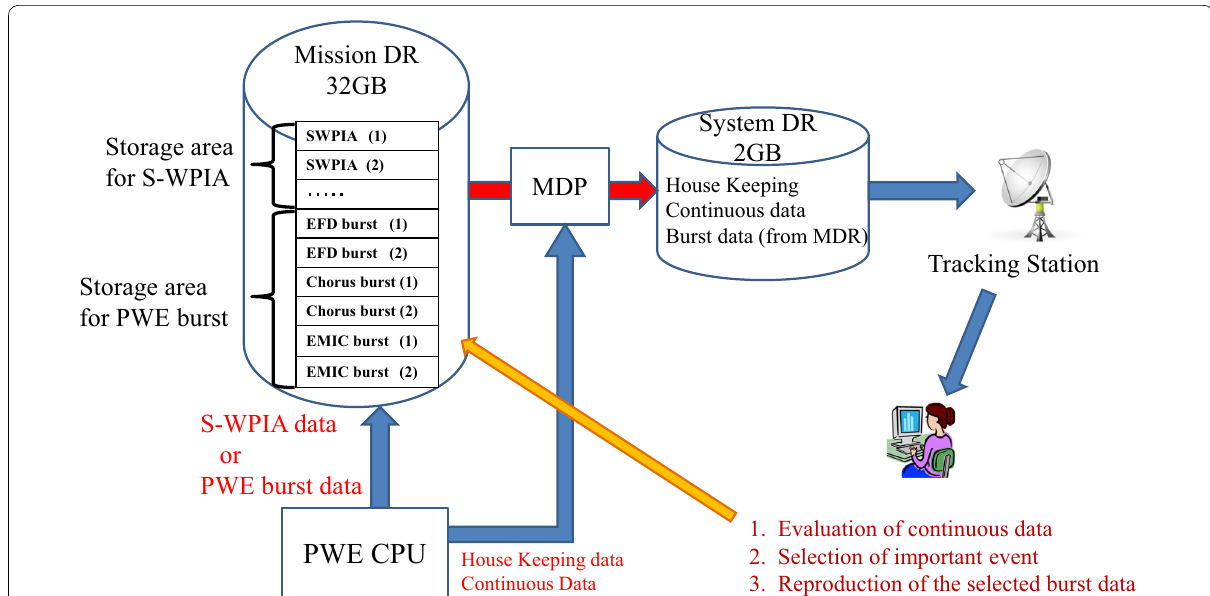
Fig. 18 Data flow of the PWE housekeeping and mission data. The housekeeping and continuous data are sent directly to the system data recorder (SDR) through the mission data processor (MDP). The PWE burst and S-WPIA data are sent to the mission data recorder (MDR) and are stored in a partition corresponding to each data type. In the data selection process, (1) we evaluate the continuous data, (2) select the burst data stored in the MDR, (3) and reproduce the selected burst data. The selected burst data are dumped to the SDR and transmitted to the